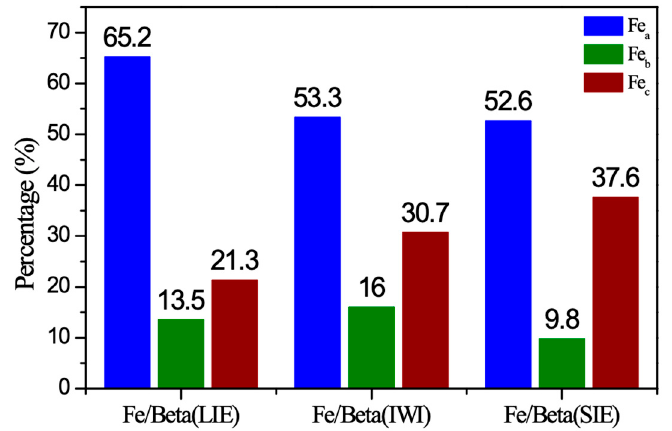
Figure 6. Percentage of various Fe species over Fe/Beta catalysts prepared by different methods. ( a ) Isolated Fe 3+ in tetrahedral and octahedral coordination, ( b ) Oligomeric Fe x O y clusters, ( c ) Fe 2 O 3 nanoparticles.